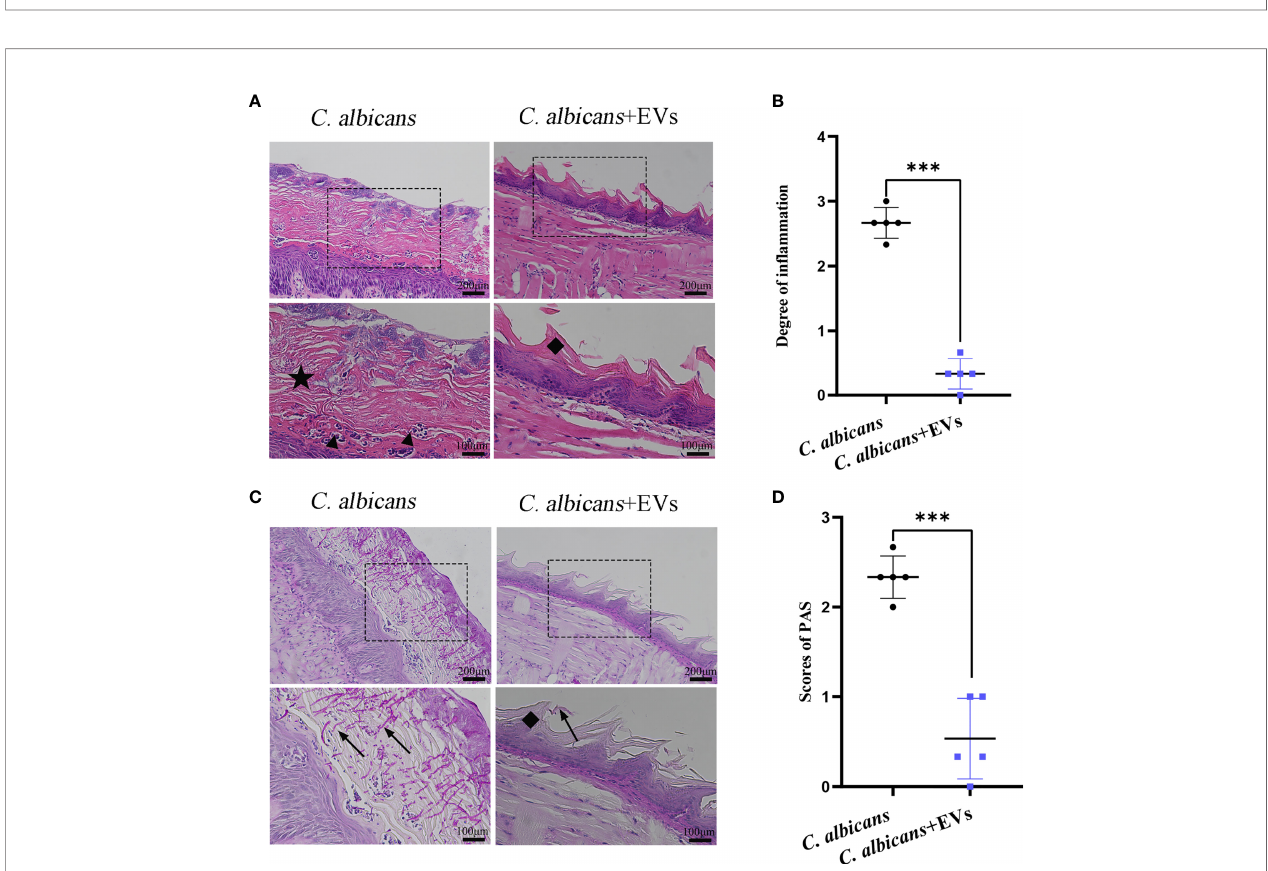
FIGURE 9 | Histopathological fi ndings of mucosal tissues of the tongue. (A) Microscopic morphology of the mucosal tissues was assessed by H&E staining. Images show that the C. albicans + EVs group has normal fi lamentous papillae, while the C. albicans group has absent fi lamentous papillae, thickened corni fi ed layer, and microabscesses forming in the epithelium. The scale bar of the upper row represents 200 m m. The scale bar of the bottom row represents 100 m m. (B) Intensity of in fl ammatory cell in fi ltration in the studied groups. The degree of in fl ammatory in fi ltration in the C. albicans + EVs group is signi fi cantly lower than that in the C. albicans group. (C) Examples of PAS staining of the mucosal tissues. The black arrow shows the invasive hyphae of C. albicans . The scale bar of upper row represents 200 m m. The scale bar of the bottom row represents 100 m m. (D) Analysis of the C. albicans invasion degree in the studied groups. The invasion degree of C. albicans hyphae is signi fi cantly higher in the C. albicans group than that in the C. albicans + EVs group. Filiform papillae ( ♦ ), corni fi ed layer ( ★ ), and microabscesses ( ▲ ). Statistical signi fi cance was tested by Student ’ s t-test. ***P < 0.001.